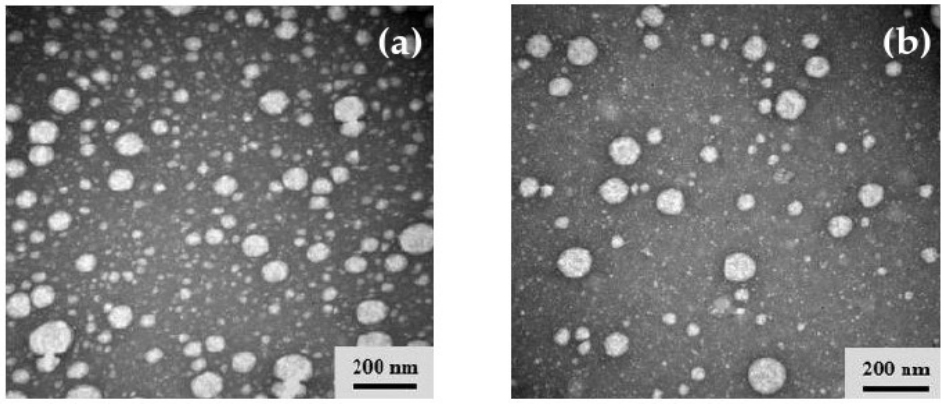
Figure 2. TEM micrographs: ( a ) Op-AG-NE and ( b ) Blank NE.